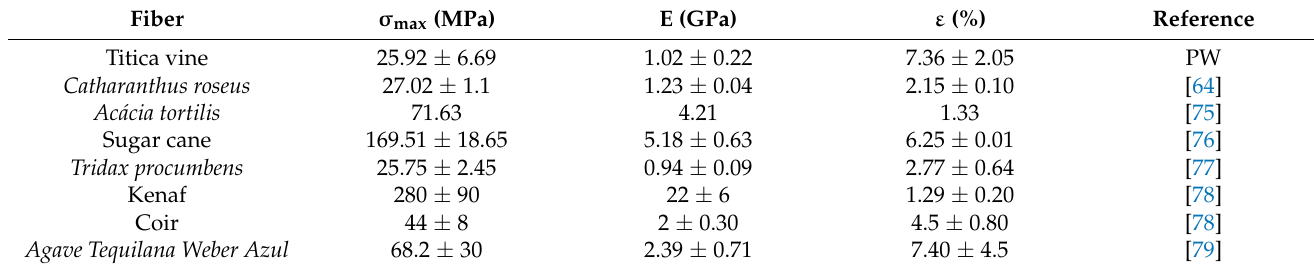
Table 7. Mechanical properties of TVFs compared to other natural fibers.